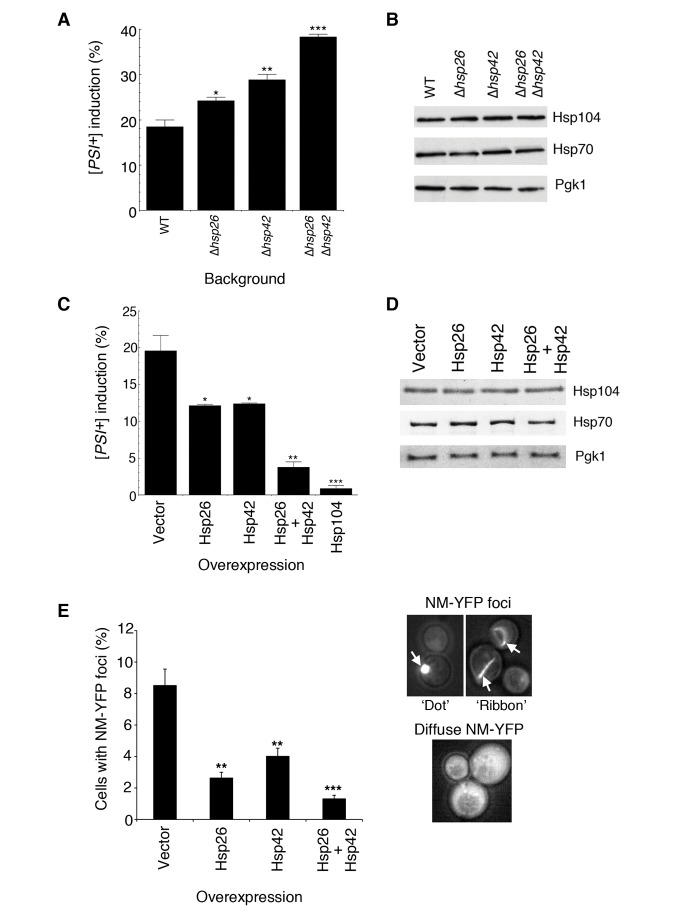
Hsp26 and Hsp42 antagonize Sup35 prion formation in vivo.(A) Sup35 was overexpressed for 16 h at 30°C in wild-type, Δhsp26, Δhsp42, or Δhsp26Δhsp42 [psi
−] [RNQ+] cells. Cells were plated on 25% YPD and the proportion of [PSI+] colonies was determined. Compared to wild-type cells there was significantly more [PSI+] induction in Δhsp26 cells (*p = 0.0264, two-tailed Student's t test), Δhsp42 cells (**p = 0.0059, two-tailed Student's t test), or Δhsp26Δhsp42 cells (***p = 0.0002, two-tailed Student's t test). Values represent means±SEM (n = 3). (B) Immunoblots demonstrating that neither Hsp104 nor Hsp70 (3A3 antibody that recognizes yeast Ssa1, Ssa2, Ssa3, and Ssa4 [95]) expression is affected in the Δhsp26, Δhsp42, or Δhsp26Δhsp42 background. Pgk1 is included as a loading control. (C) Sup35 was overexpressed for 16 h at 30°C in [psi
−] [RNQ+] cells expressing elevated levels of Hsp26, Hsp42, Hsp26 plus Hsp42, or Hsp104. Cells were plated on 25% YPD and the proportion of [PSI+] colonies was determined. Compared to the vector control there was significantly less [PSI+] induction in cells expressing Hsp26 (*p = 0.0253, two-tailed Student's t test), Hsp42 (*p = 0.028, two-tailed Student's t test), Hsp26 and Hsp42 (**p = 0.0021, two-tailed Student's t test), or Hsp104 (***p<0.0001, two-tailed Student's t test). Values represent means±SEM (n = 3). (D) Immunoblots demonstrating that neither Hsp104 nor Hsp70 (3A3 antibody that recognizes yeast Ssa1, Ssa2, Ssa3, and Ssa4 [95]) expression is affected by elevated expression of Hsp26, Hsp42, or Hsp26 and Hsp42. Pgk1 is included as a loading control. (E) NM-YFP was transiently overexpressed for 4 h at 30°C in [psi
−] [RNQ+] cells expressing elevated levels of Hsp26, Hsp42, or Hsp26 and Hsp42. Cells were processed for fluorescence microscopy. The proportion of cells with NM-YFP foci was then determined. (**p<0.01, ***p<0.001, two-tailed Student's t test). Values represent means±SEM (n = 3). Examples of cells with NM-YFP foci (“dots” and “ribbons” indicated by arrows) and cells with diffuse NM-YFP fluorescence are shown on the right.